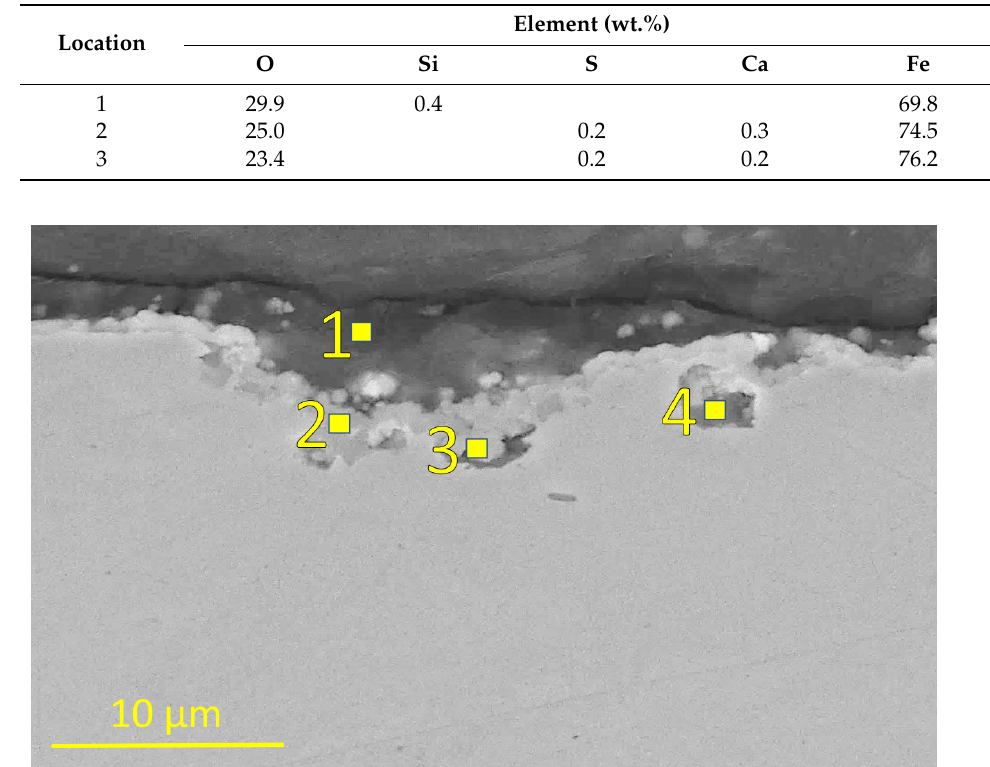
Figure 9. Cross-section in the centre of the tested carbon-steel sample 5 in the middle of the second reactor. Table 9. Elemental analysis from locations in Figure 9.